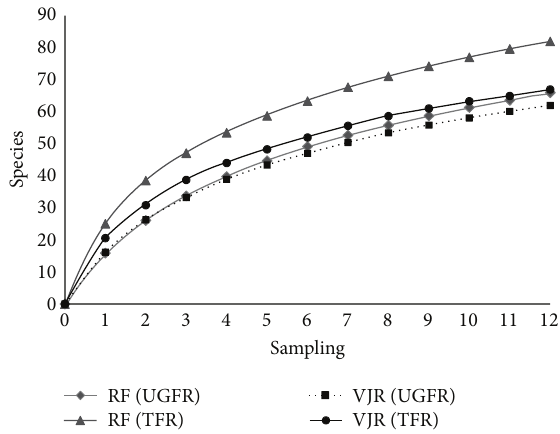
Figure 2: Species accumulation curve of understorey birds captured in different habitats and at different